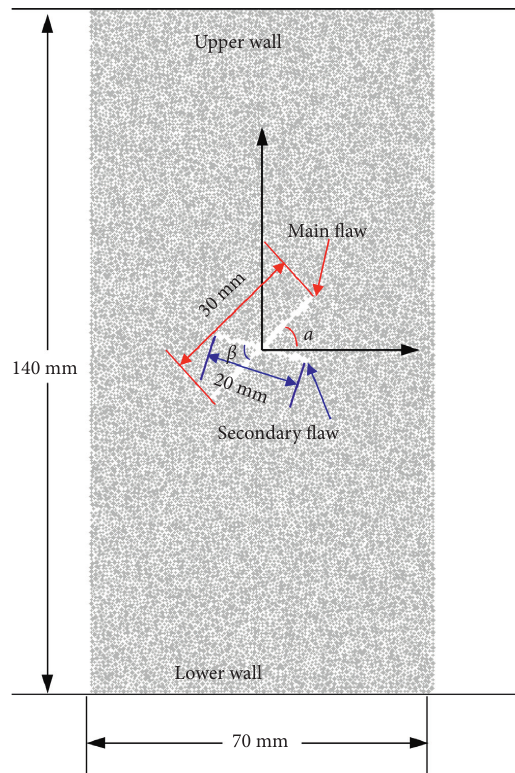
Figure 1: Numerical model for granite specimens containing crossing-double-flaws of different lengths. Table 1: Microparameters of granite specimen [38, 39]. Microparameters Values Minimum particle radius (mm) 0.3 Ratio of maximum to minimum of radius 1.66 Particle density (kg/m 3 ) 2800